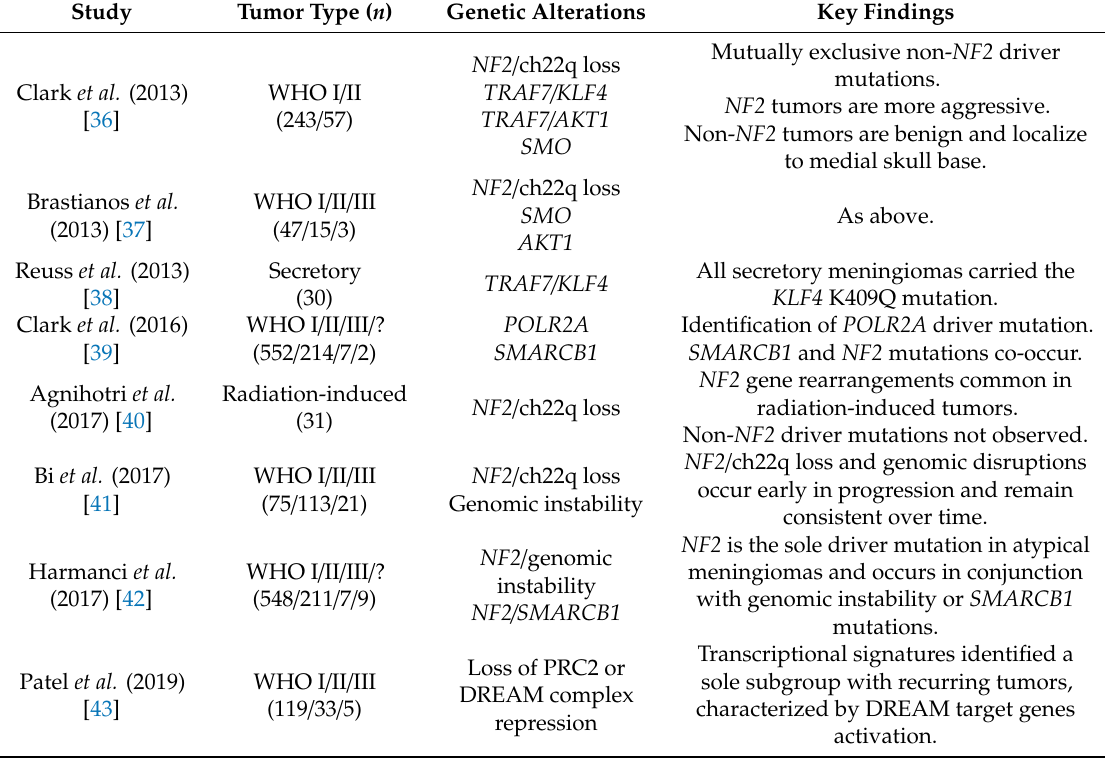
Table 2. Summary of next-generation sequencing (NGS)